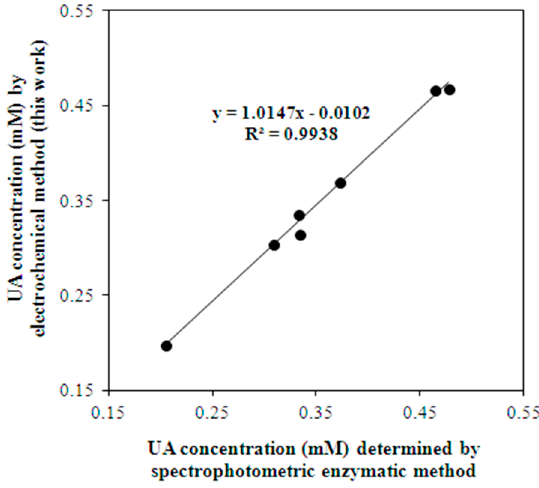
Figure 8. Correlation between results of UA determination in blood serum samples obtained by the enzymatic spectrophotometric method and the proposed electrochemical method.